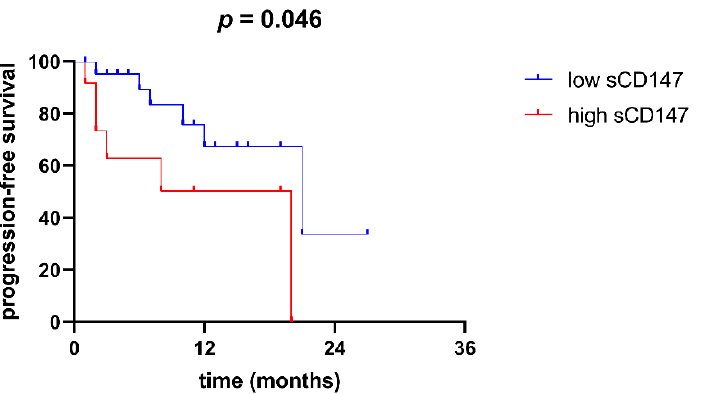
Figure 4. Progression-free survival of patients with high serum sCD147 (above the upper quartile, or 5798.96 pg/mL) and in patients with low serum sCD147 (below the upper quartile). Patients with high sCD147 are characterized by a more adverse PFS ( p = 0.046).